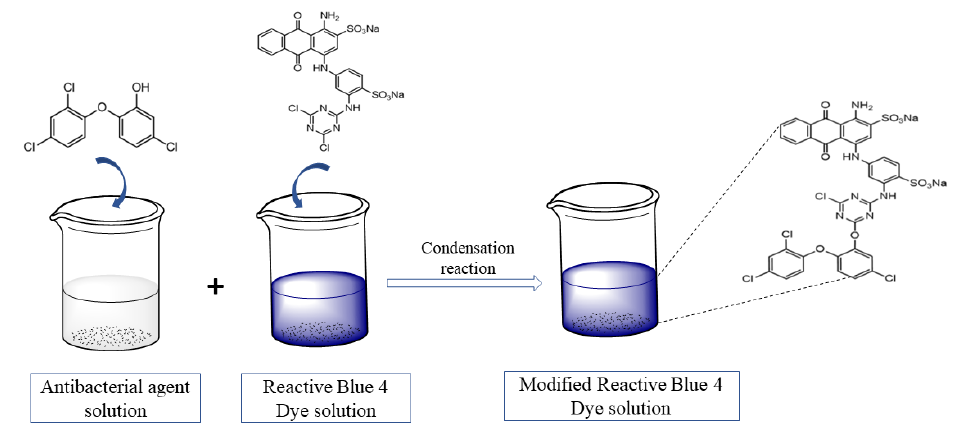
Figure 4. Schematic illustration of the functionalization of dye. The schematic showing the application of the modified dye on the copper-treated fabric is shown in Figure 5.